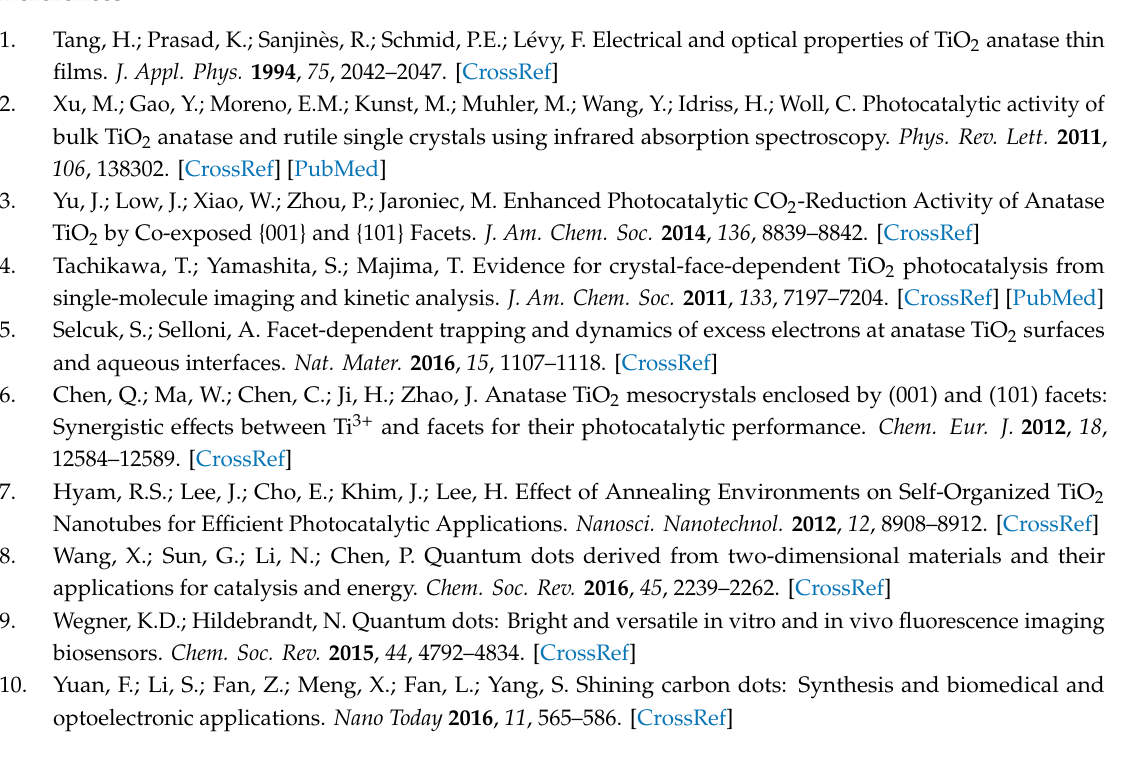
Figure S1: (a) Slab model of anatase TiO 2 single crystal. (b) Equilibrium model of anatase TiO 2 single crystal. (Calculation method of the percentage of {001} facets). Figure S2: (a) Raman spectra of di ff erent TiO 2 samples without and with NGQDs decoration. (b) Raman spectra of T1 before and after decoration of NGQDs. The inset in Figure S2 b is the enlargement of 1200–1700 cm − 1 of T1-NGQDs. Figure S3: TEM images of (a) T0, (b) T1, (c) T2, and (d) T3. Figure S4: (a) TEM image, (b) HRTEM image, (c) AFM image, (d) UV-vis spectra and PL spectra of the GQDs (the excitation wavelength is 365 nm), (e) Raman spectra, and (f) XRD pattern of NGQDs. The inset in (a) is the size distribution of NGQDs. The inset in (b) is the autocorrelated HRTEM lattice images recorded. Figure S5: HRTEM images of the anatase TiO 2 decorate with NGQDs. Figure S6: (a) The photocatalytic degradation of di ff erent pollutants for T1-NGQDs, (b) plot of k values for di ff erent pollutants degradation in